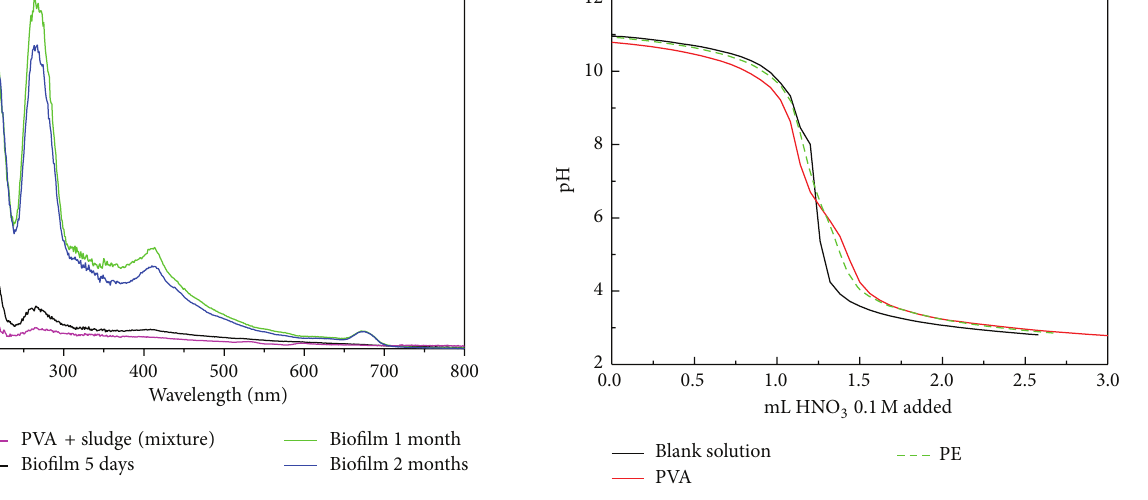
Figure4:Potentiometrictitrationscurvesfortheblanksolutionand the biofilms formed on PVA and PE